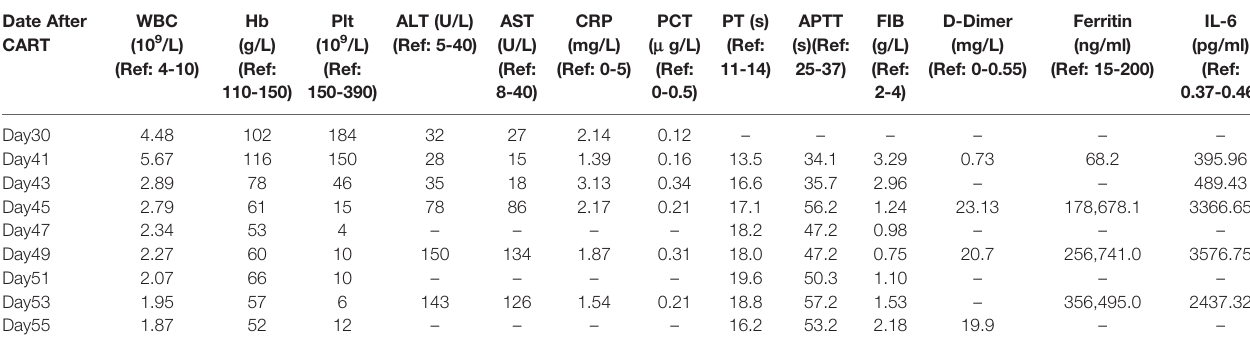
TABLE 1 | The laboratory results in Case